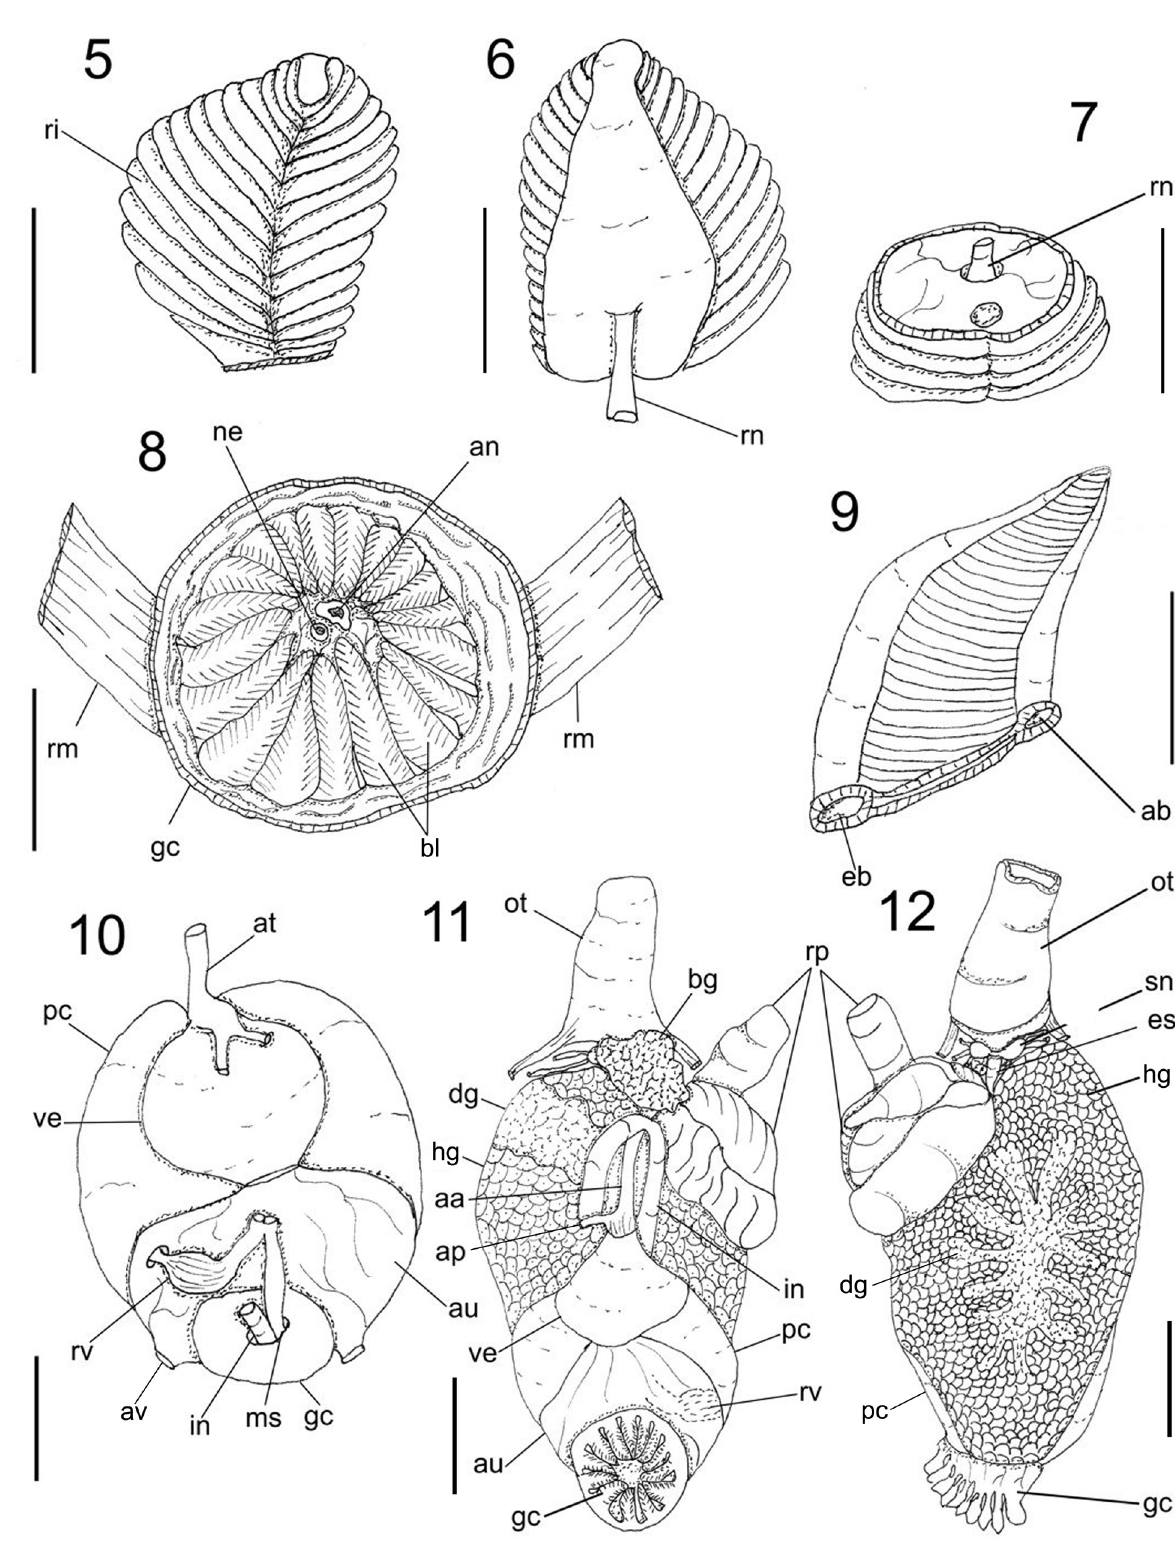
Figures 5–12. Anatomical details of Actinocyclus verrucosus . 5. Rhinophore extracted, ventral view, scale: 0.5 mm. 6. Same dorsal view, scale: 0.5 mm. 7. Same, transverse section, scale: 0.5 mm. 8. Gill circle with retractor muscle, dorsal view, scale: 1 mm. 9. Detail of gill filament, scale: 1 mm. 10. Detail of circulatory system (structures of pericardium), ventral view, scale: 2 mm. 11. Ex- tracted visceral mass, dorsal view, scale: 2 mm. 12. Same, ventral view, scale: 2